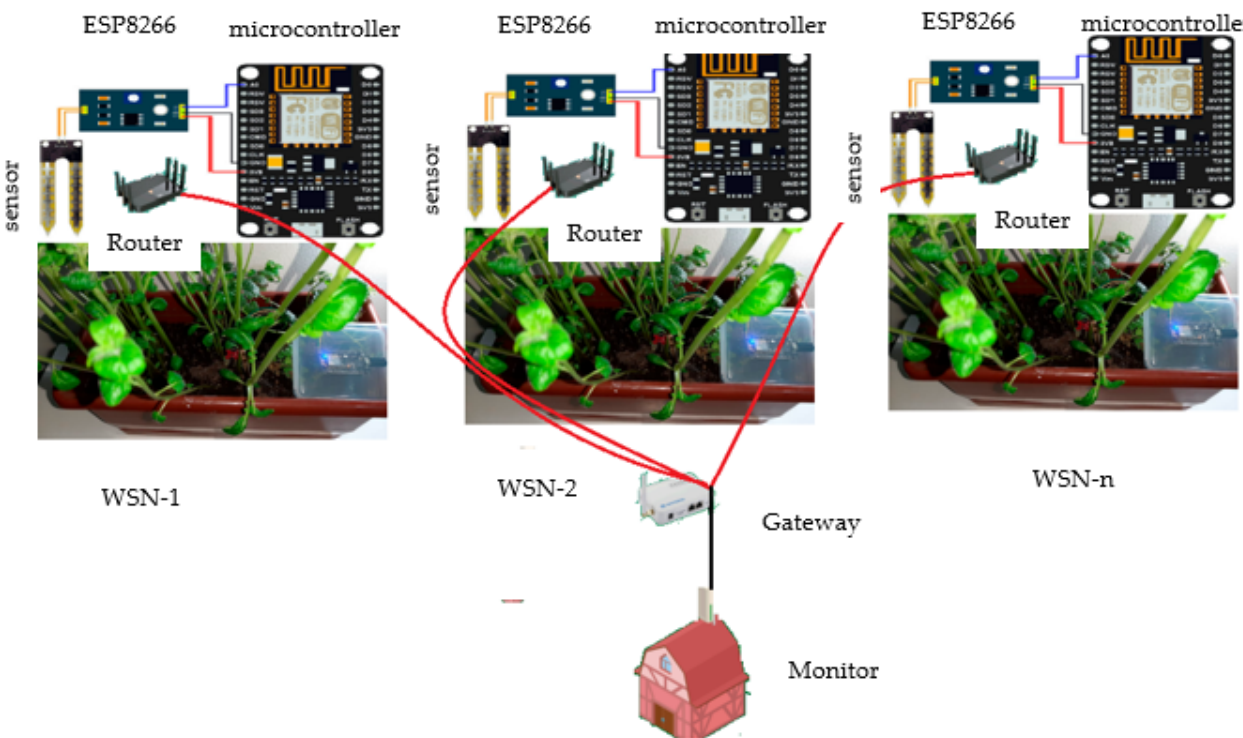
Figure 4. Implementation of IOT-based systems at medium and large scales.